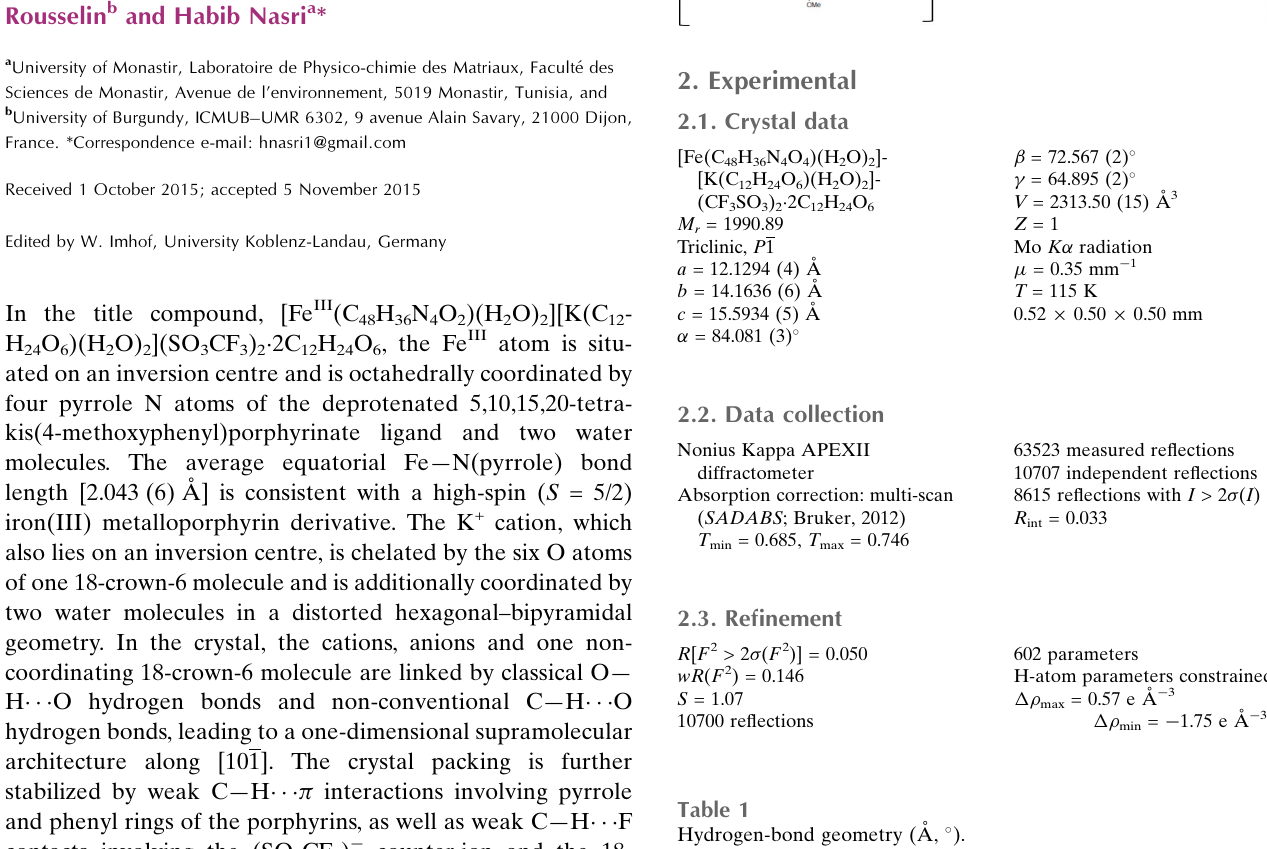
Hydrogen-bond geometry (A˚ , (cid:4)